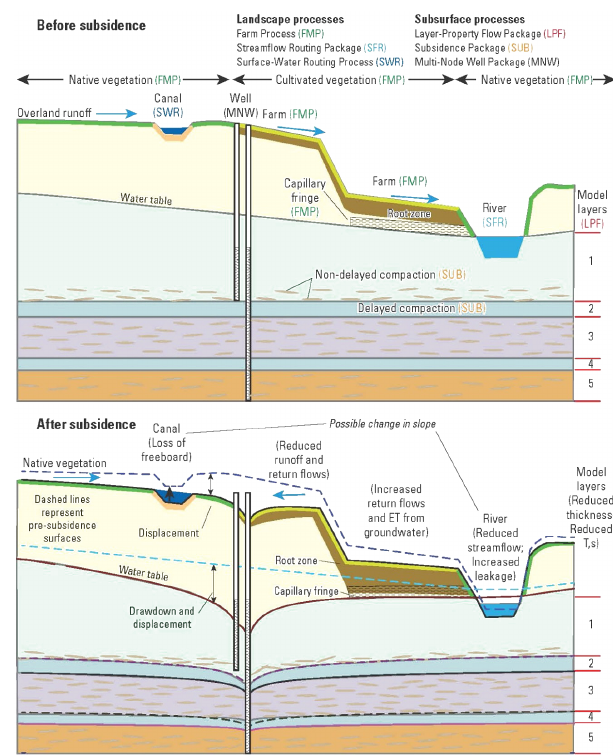
Figure 2. Diagram showing the relation between surface and sub- surface processes with linkage to land subsidence (Schmid et al., 2014; Hanson et al.,